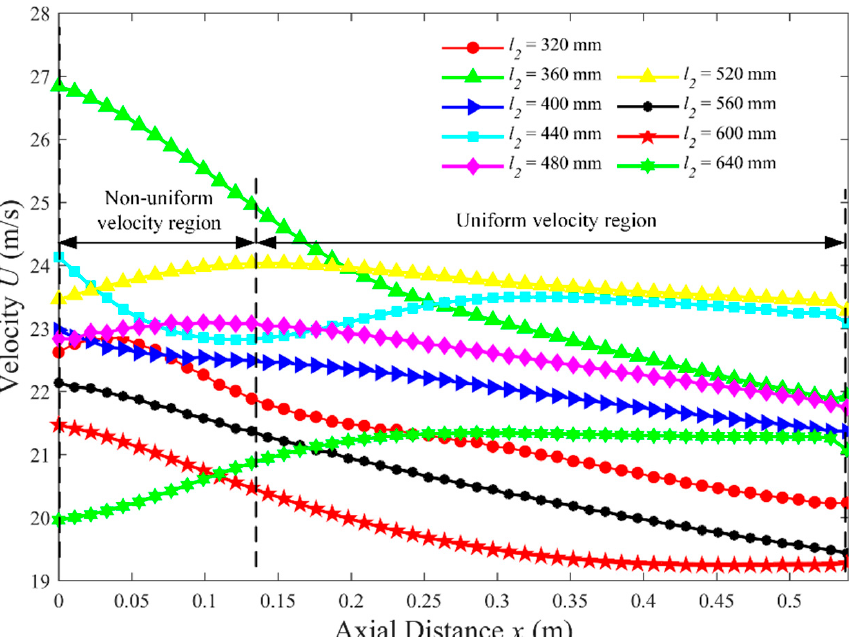
Figure 5. Variation of wind velocity distribution with axial distance under different contraction lengths.